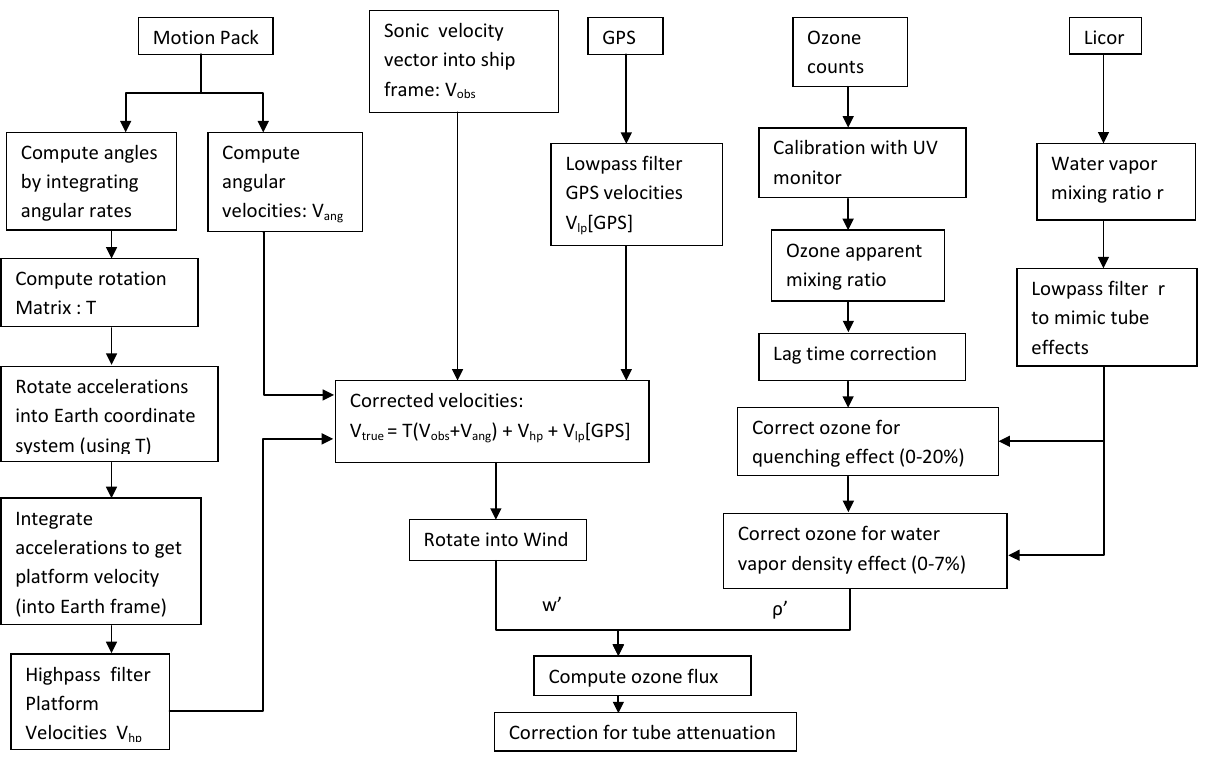
Fig. 4. Flowchart showing the steps in the ozone flux computation (including the water vapor interference correction). T is the rotational coordinate transformation matrix as defined in Edson et al.